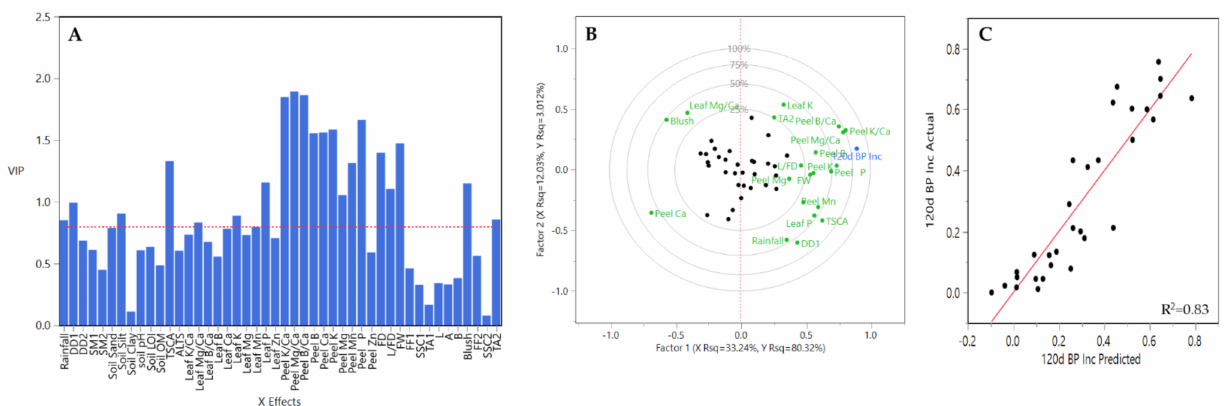
Figure 13. Results obtained from the partial least square (PLS) analysis between BP incidence at 120 DAH and the rest of variables evaluated all three years together for M.26 rootstock in HV and CV. ( A ) Important X variables in the PLS model, ( B ) correlation loading plot, and ( C ) observed values versus PLSR-predicted values for BP. Abbreviations: ALTS: average length terminal shoot; DD1: degree days accumulated from 1st of January to harvest date; DD2: degree days accumulated from 60 days post-bloom; FD: fruit diameter; FF1: flesh firmness at harvest; FF2: flesh firmness after storage; FW: fruit weight; L: length; SSC1: soluble solids content at harvest; SSC2: soluble solids content after storage; SM1: average soil moisture 12 weeks prior to harvest; SM2: average soil moisture from 1st of January to harvest date; TA1: titratable acidity at harvest; TA2: titratable acidity after storage; TCSA: trunk cross-sectional area.